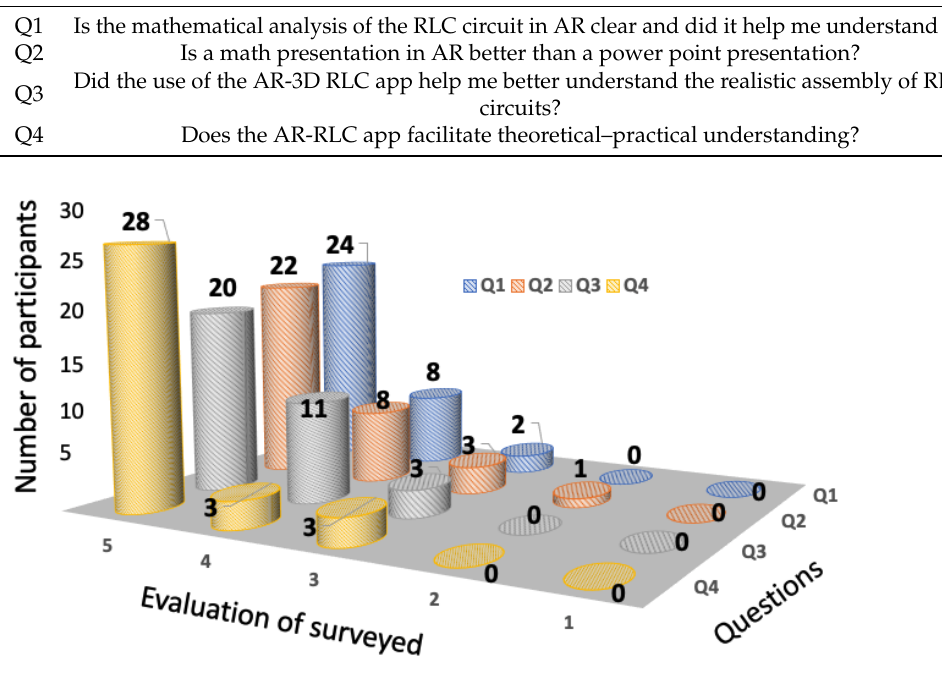
Figure 12. AR-RLC circuits’